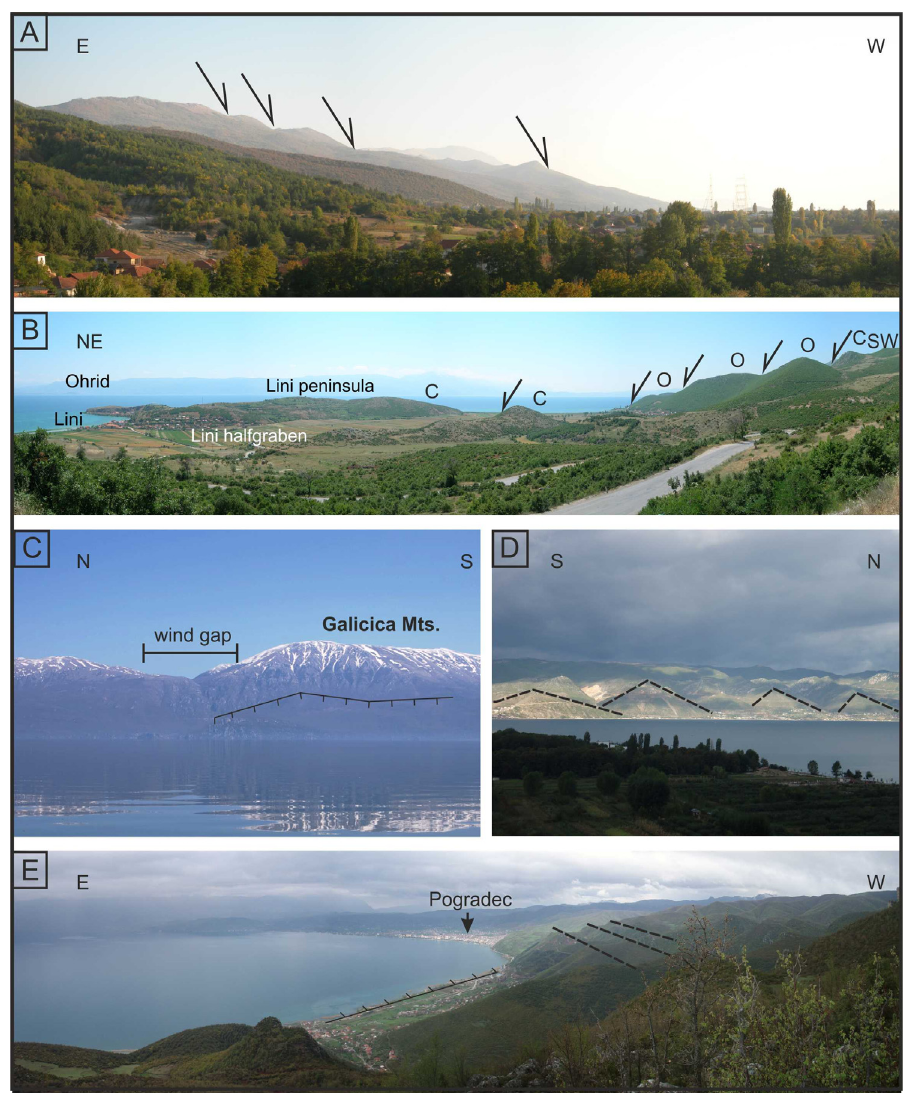
Figure 2. (A): Staircased landscape at the slope of Galicica Mountains. Arrows show orientation of normal faults. View to south. (B): Panoramic view of Lini Peninsula and Mokra Mountains showing tectonic features. o= ophiolites, c=carbonates, arrows indicate orienta- tion of normal faults. View to southeast. (C): E-W trending wind gap at Galicica Mountains, probably developed as an old fault or discharge connection between Lake Prespa and Ohrid. Black line shows fault trace. View to east. (D): Triangular facets on the west coast (Hudenisht area). View to west. (E): Panoramic view of the southwestern coast. Dashed line shows inferred fault traces (see also Figure 1). Note the fault- cut alluvial fan. View to